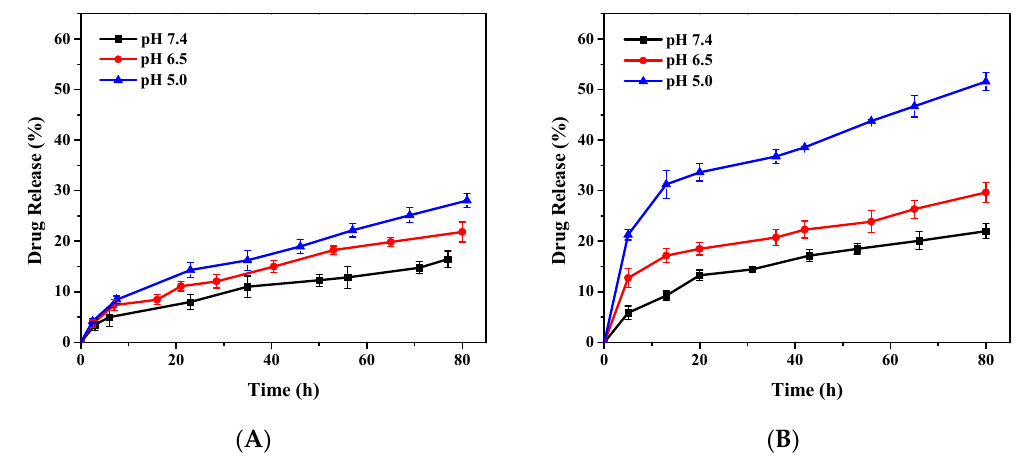
Figure 6. In vitro PTX release profiles of drug-loaded micelles ( A ) CA-CP and ( B ) CA-CDEP at 37 °C with different pH.